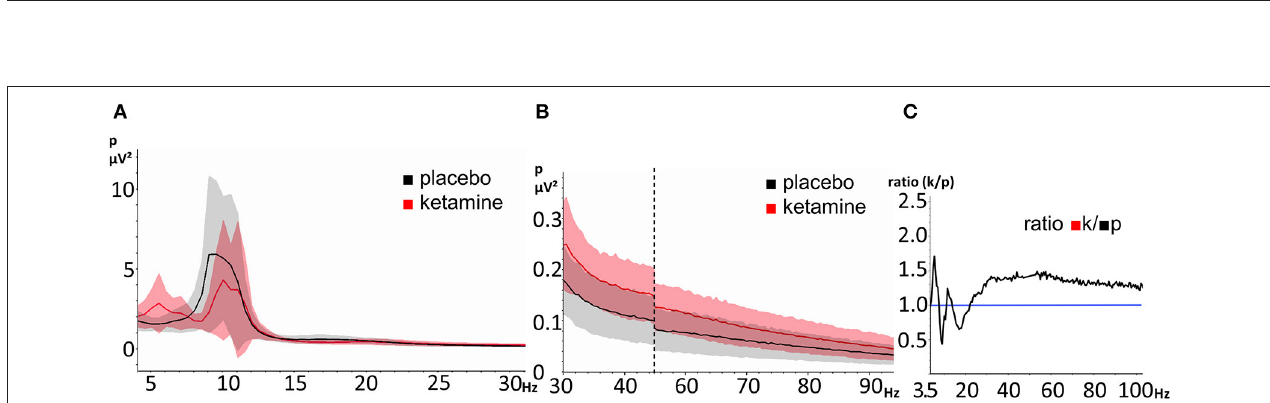
FIGURE 2 | Bar charts of the mean values of the 11 subscales of the 5D-ASC-scale with error bars representing ± 1 standard errors of the mean (** p < 0.01;*** p < 0.001).